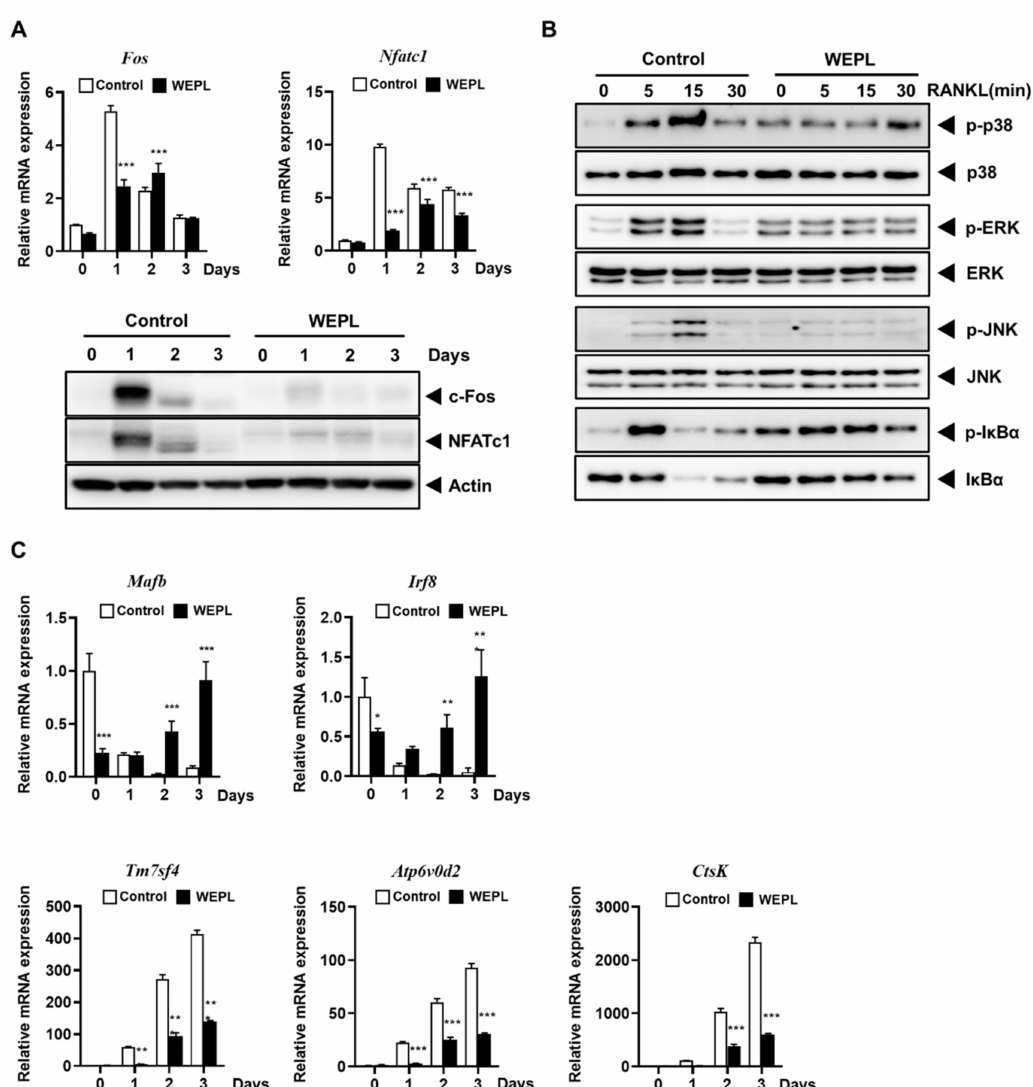
Figure 3. Effects of WEPL on the expression levels of osteoclastogenic transcription factors and osteoclast-specific genes. BMMs were incubated with M-CSF and RANKL in the presence or absence of WEPL (100 µ g/mL) for the indicated times. ( A ) The mRNA and protein levels of c-Fos and NFATc1 were analyzed by PCR and western blotting. ( B ) BMMs were stimulated with RANKL, 3 h after pre-treatment with WEPL. The expression levels of MAPKs (p38, ERK, and JNK) and I κ B α was detected using western blot. ( C ) The mRNA expression of negative regulators ( Mafb and Irf8 ) and osteoclast-specific genes ( Tm7sf4 , Atp6v0d2 , and CtsK ). * p < 0.05, ** p < 0.01, *** p < 0.001 vs